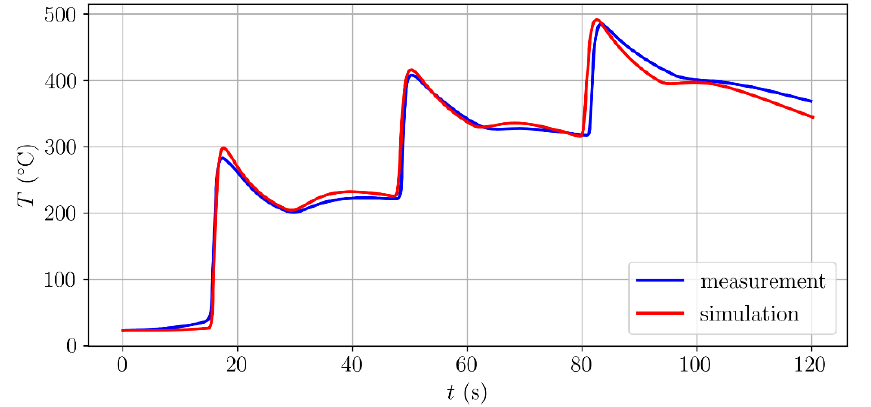
Figure 11. Time evolution of temperature at thermocouple no. 6.